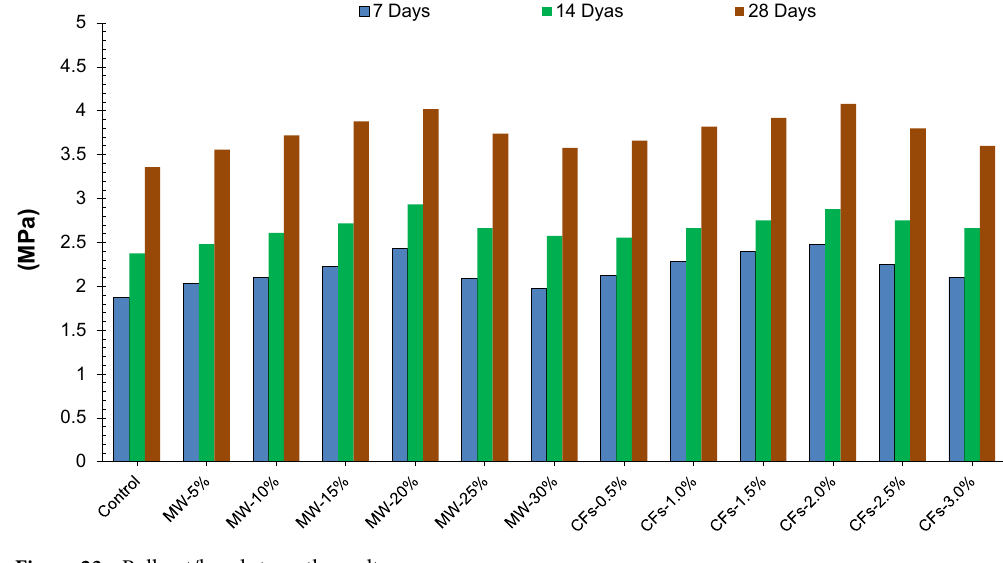
Figure 23. Pull out/bond strength results.